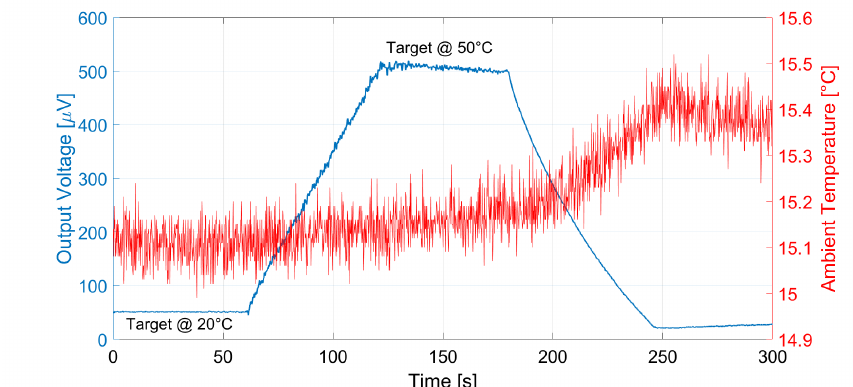
Figure 11. Measured thermopile E1 output with the black body at 10 cm distance and ambient temperature equal to 15 ◦ C. The black body temperature was varied as a ramp from 20 to 50 ◦